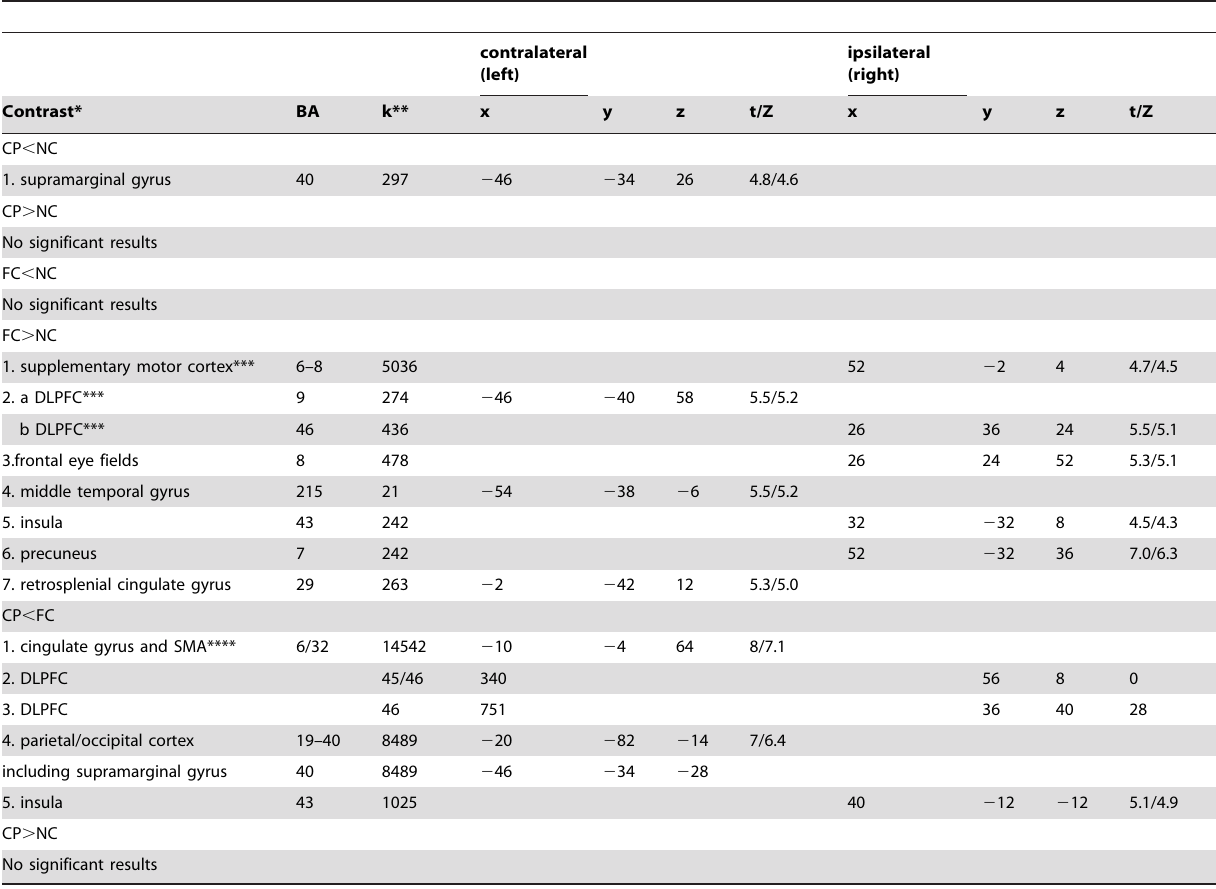
Table 8. Cerebral activation related to movement imagery on the unaffected hand (left-sided patients and feigners were flipped).